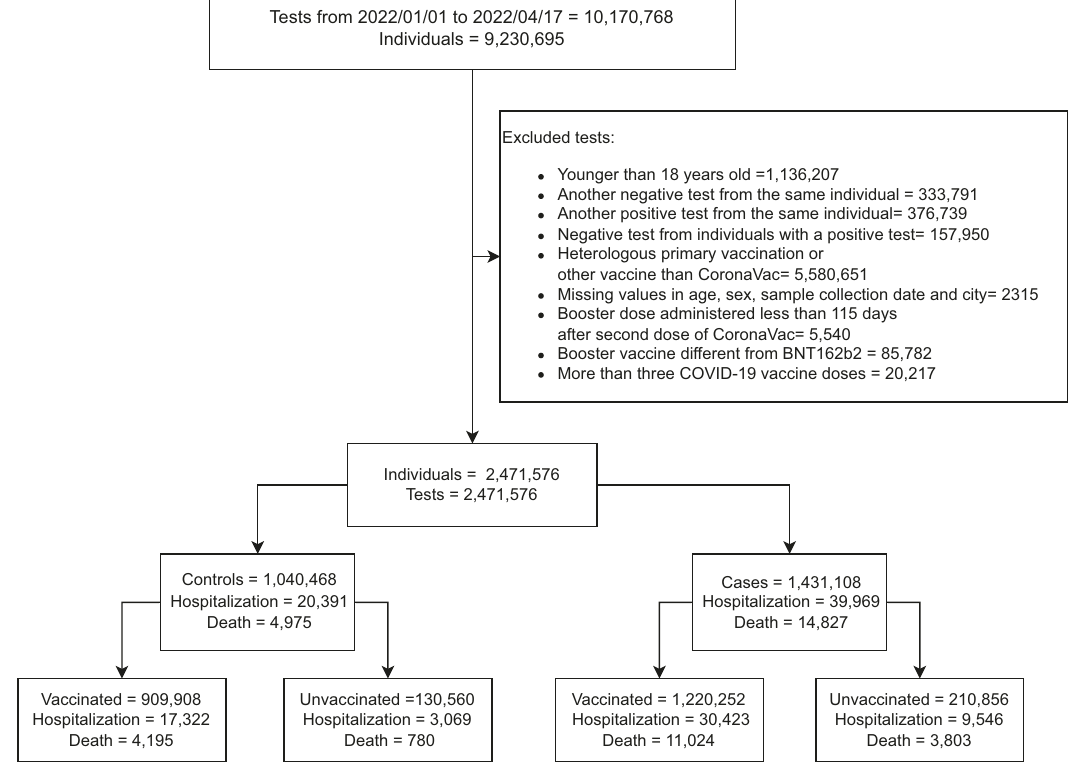
Fig. 1 Flowchart of the study population from surveillance databases and selection of cases and controls. Only lateral fl ow or RT – PCR tests with the sample collected within 10 of symptom onset were considered eligible. Sensitivity analysis was performed by removing unvaccinated individuals (cases and